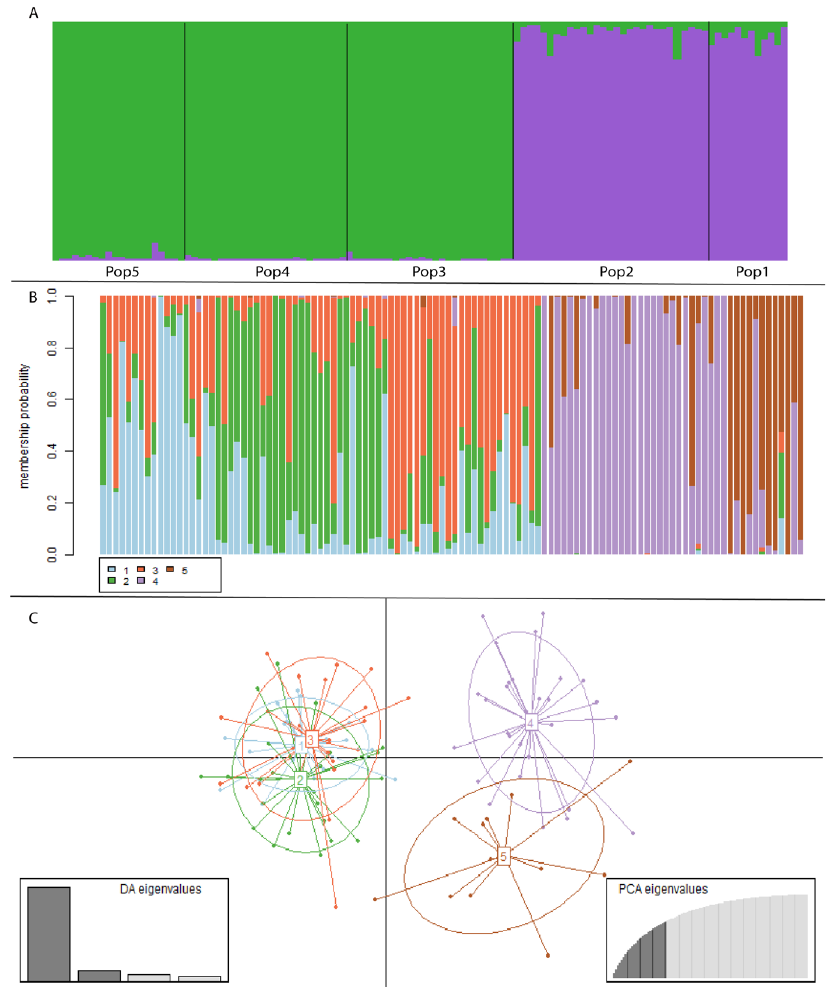
FIGURE 3 | A. Salminus brasiliensis population structure from the Bayesian cluster analysis for K = 2 (see also S1 ). Black lines separate the different sampled populations based on location (Pop1, Pop2, Pop3, Pop4 and Pop5; Fig. 1). B . DAPC scatterplots and membership probabilities show the first two principal components of the DAPC. Populations are represented in different colors: 1 - Lilac (Pop5); 2 - Green (Pop4), 3 - Orange (Pop3), 4 - Lilac (Pop2) and 5 - Brown (Pop1). C . Membership probabilities (in bar plots), represent individuals in different